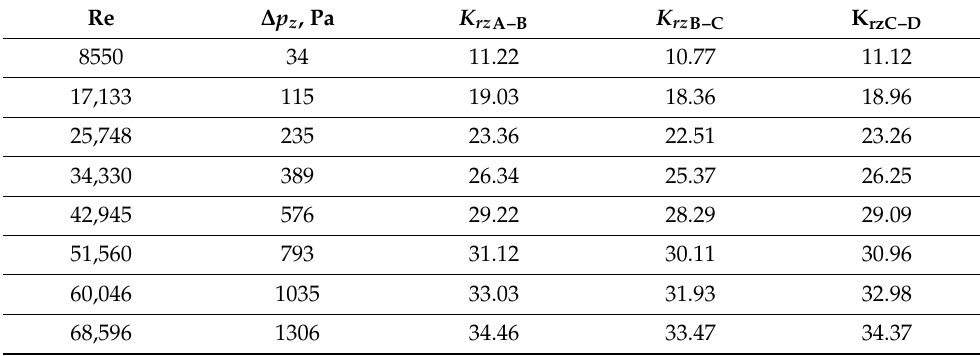
Table 2. Dependence of the coefficient of friction anisotropy on the Reynolds number.